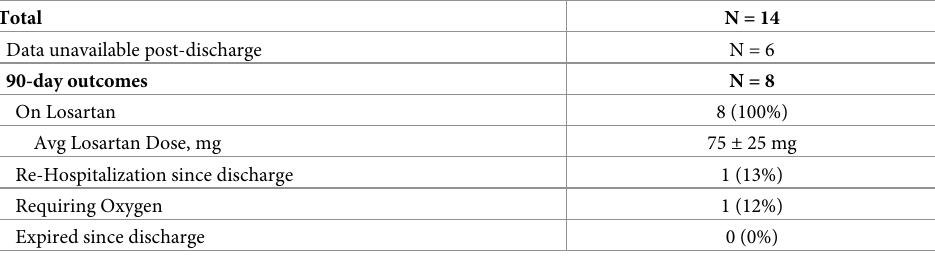
Table 7. Post-discharge outcomes in retrospective cohort at 90 days. Total N = 14 Data unavailable post-discharge N = 6 90-day outcomes N = 8 On Losartan 8 (100%) Avg Losartan Dose, mg 75 ± 25 mg Re-Hospitalization since discharge 1 (13%) Requiring Oxygen 1 (12%) Expired since discharge 0 (0%) Data is presented as Number and percentage, Mean ± Standard